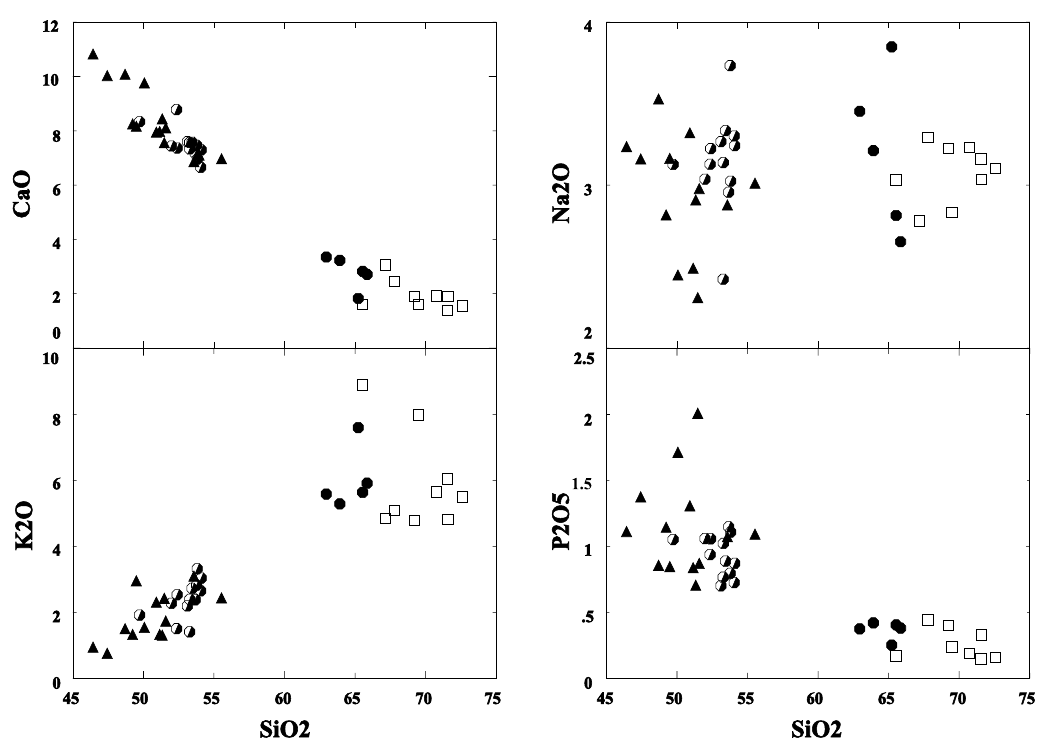
Fig. 2b – Harker diagramas for the rocks of theVAIC. Symbols: (cid:1) Opx-gabbro; ◗ qz-diorites to qz-monzodiorites; (cid:3) sphene qz-syenite; ❒ megagaporphyritic granite.